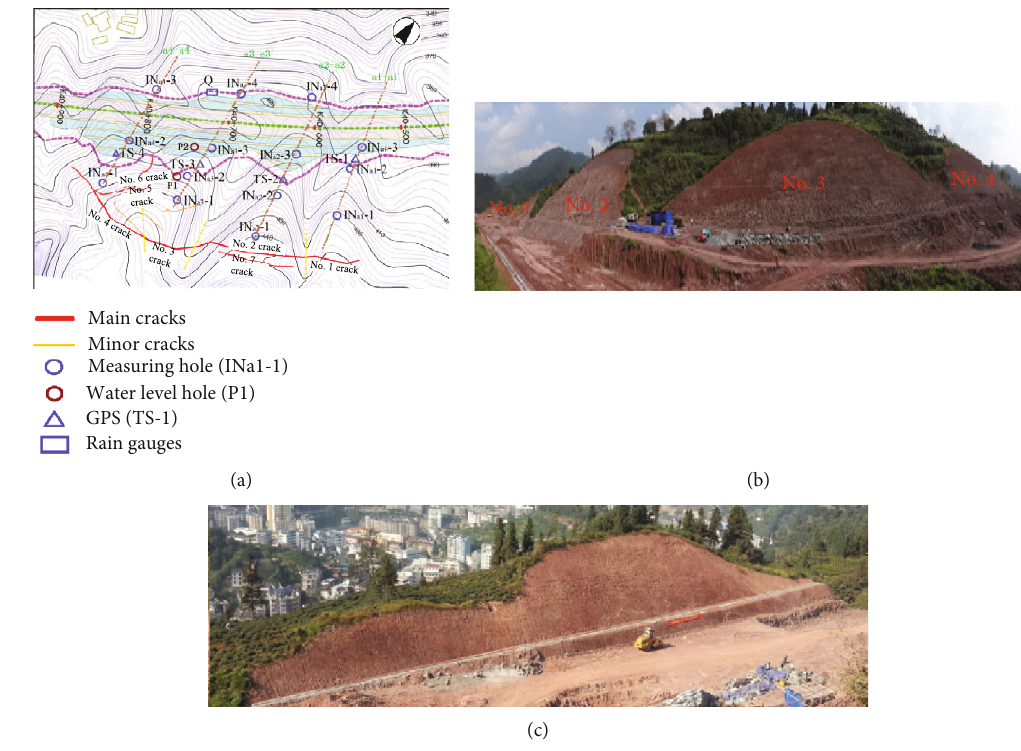
Figure 1: Slope topographic map: (a) monitoring section, (b) left side, and (c) right